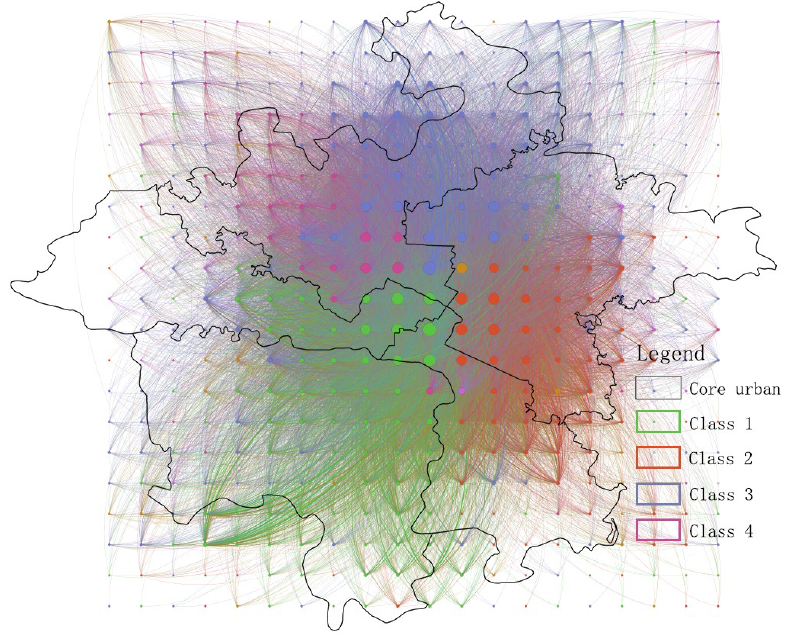
Figure 8. Community structure and small world characteristics of traffic flow network. (The graph density is 0.115, the average degree is 45.788, and the average weighted degree is 513.745; class is also referred to as community in this